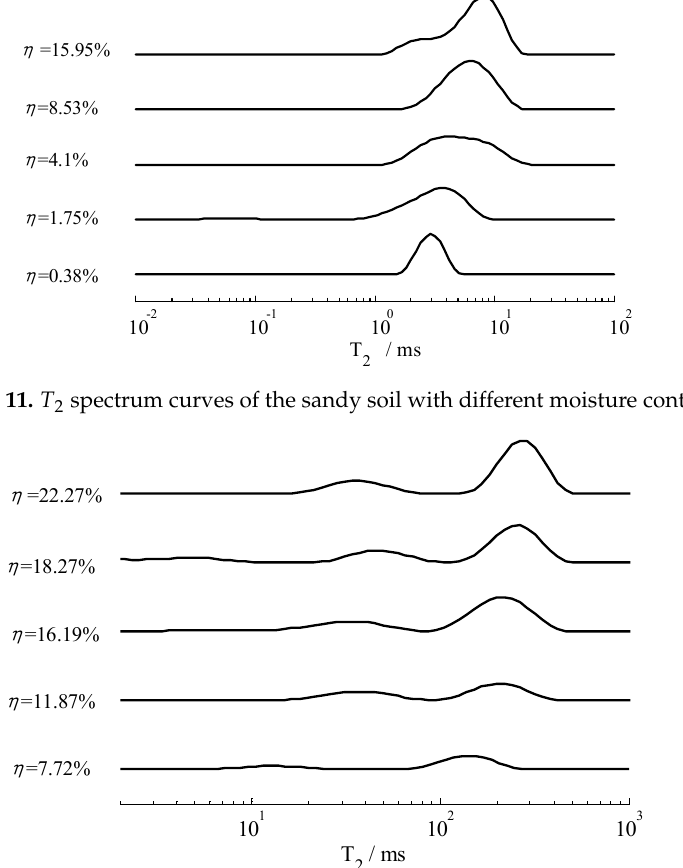
Figure 14. Correspondence between the integral area of the T 2 spectrum with the moisture content of the silica sand. 4. Conclusions In this work, we presented a mini NMR sensor that combines three cylindrical magnets to measure moisture content effectively in sandy soil and silica sand. The sensor has a constant gradient of 2.28 T/m. A novel RF coil composed of three arc spiral coils of the same size connected in series was designed for inside-out NMR applications. The coil demonstrated a high SNR, mostly due to an enhancement in the sensitivity region. The complete decaying NMR signal was analyzed through inverse Laplace transformation on the T 2 space, which could estimate the moisture content of the samples. This mini sensor is portable, and the sensitive region is relatively larger than its actual size. In conclusion, this mini NMR sensor has been demonstrated to be a fast and a noninvasive technique for investigating the moisture content of soils. Moreover, this mini sensor may allow easy on-field soil moisture measurements in the future. Further research should focus on applying this sensor to pore media measurement, thereby improving stability and detection depth by further optimizing the sensor structure. Author Contributions: Conceptualization, J.W. and P.G.; methodology, J.W. and Y.H.; software, Y.H.; validation, Z.X.; formal analysis, J.W. and S.S.; investigation, J.W. and P.G.; resources, Z.X. and P.G.; data curation, S.S.; writing—original draft preparation, J.W.; writing—review and editing, J.W. and P.G.; visualization, X.H.; supervision, Z.X.; project administration, Z.X.; funding acquisition, Z.X. and P.G.. 5